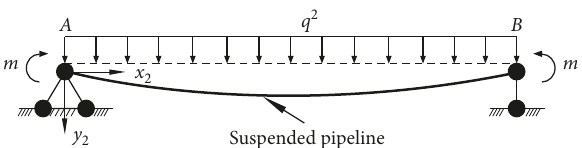
Figure 2: Calculation model for the suspended